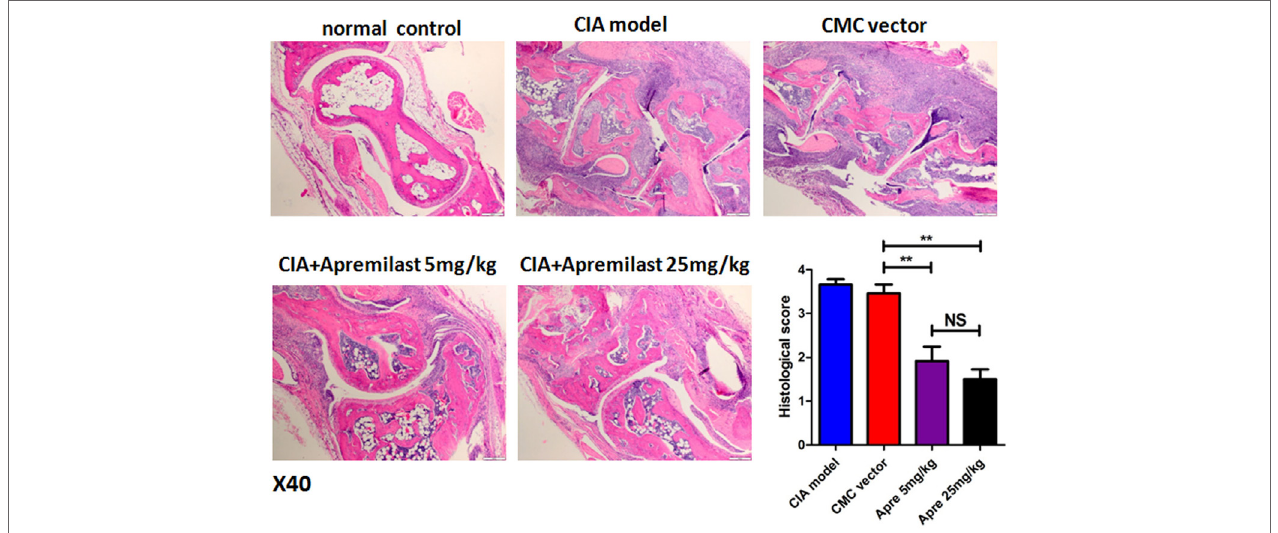
FigUre 2 | Apremilast administration reduced arthritis pathology in collagen-induced arthritis (CIA) model. Ankle joint sections were stained with hematoxylin and eosin 56 days after the primary immunization and evaluated for the histopathologic features of synovitis, pannus, and erosion (representative results were shown; 40 × ) in Apremilast (5 or 25 mg/kg), CMC vehicle alone, CIA model, and normal groups. Results were expressed quantitatively as the histopathology score (right lower panel). The data indicate the mean ± SEM of two separated experiments, each group with five mice. Data were analyzed using the one-way ANOVA for comparison among multiple groups, followed by Turkey’s test (** p < 0.01).